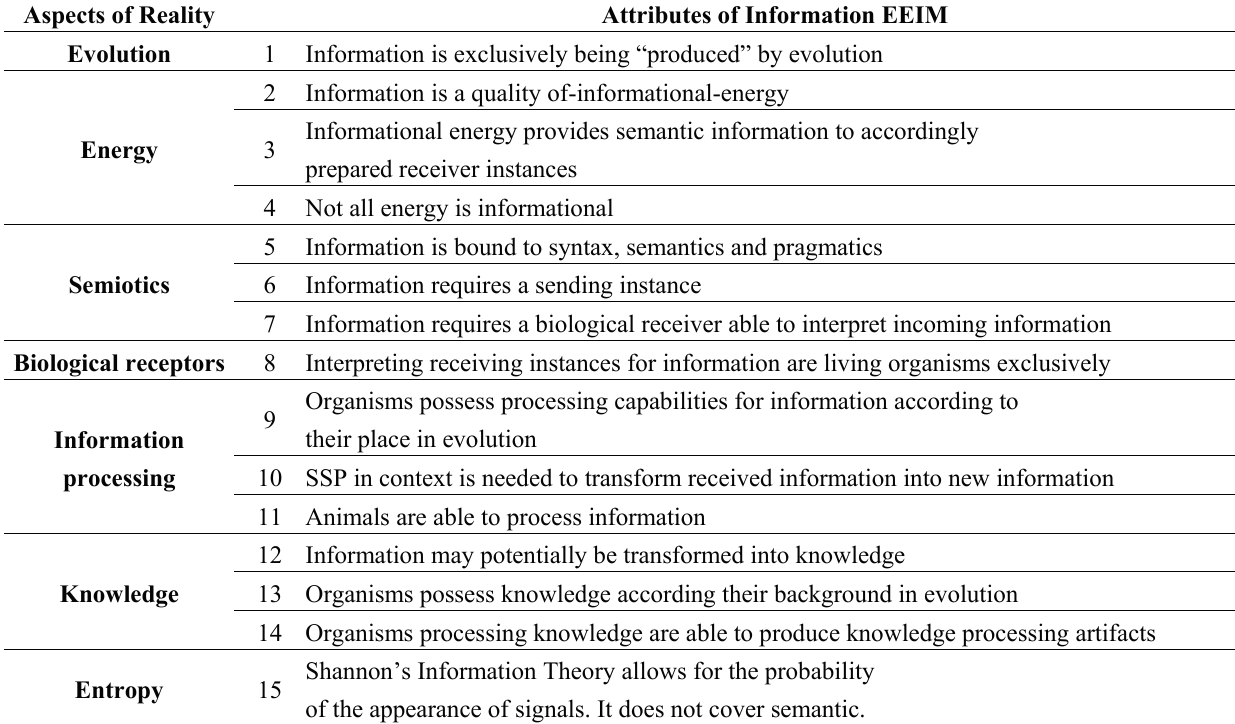
Table 1. Characteristics of Evolutionary Energetic Information Model (EEIM). A mapping between aspects of reality and model attributes is